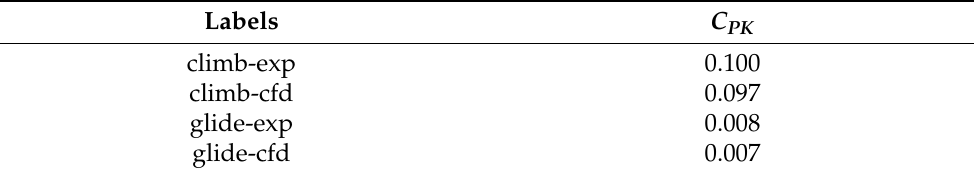
Table 2. C PK of the DPD aircraft at climbing and glide conditions.